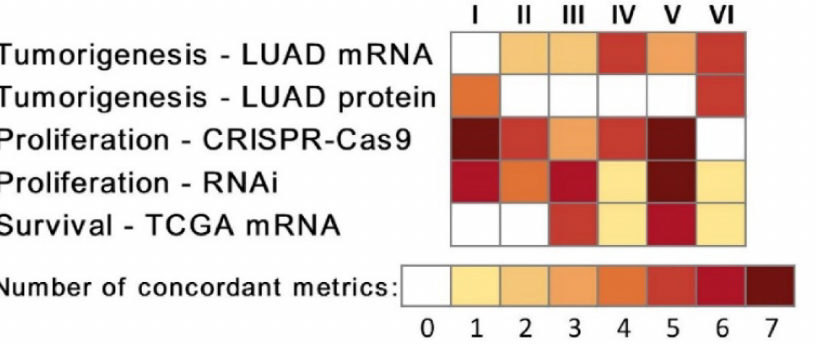
Figure 1. Concordance of correlation coefficients between seven centrality metrics of the selected networks with NSCLC tumorigenesis, proliferation, and patient survival. Tumorigenesis was de- scribed with the t statistics (two-sample t tests) of tumor vs. NAT differential expression in mRNA ( n tumor = 51, n NAT = 49) and protein ( n tumor = n NAT = 103) datasets in Xu’s LUAD patients [39]. Pro- liferation was assessed in human NSCLC cell lines with dependency scores in in vitro CRISPR-Cas9 ( n = 94) and RNAi ( n = 92) genome-wide screening. Patient survival was represented by hazard ratios in univariate Cox modeling of TCGA RNA sequencing data of NSCLC patient tumors ( n = 1016). Each cell in the figure showed the number of metrics with concordant significant Pearson’s correlation coefficients in a pair of compared networks: I. CNV–CNV networks (GSE28582 and GSE31800); II. CNV-mediated GE networks (GSE28582 and GSE31800); III. gene co-expression networks (GSE28582 and GSE31800); IV. gene co-expression networks (Xu’s LUAD tumors and NATs [39]); V. mRNA- mediated protein expression networks (Xu’s LUAD tumors and NATs [39]); VI. protein co-expression networks (Xu’s LUAD tumors and NATs